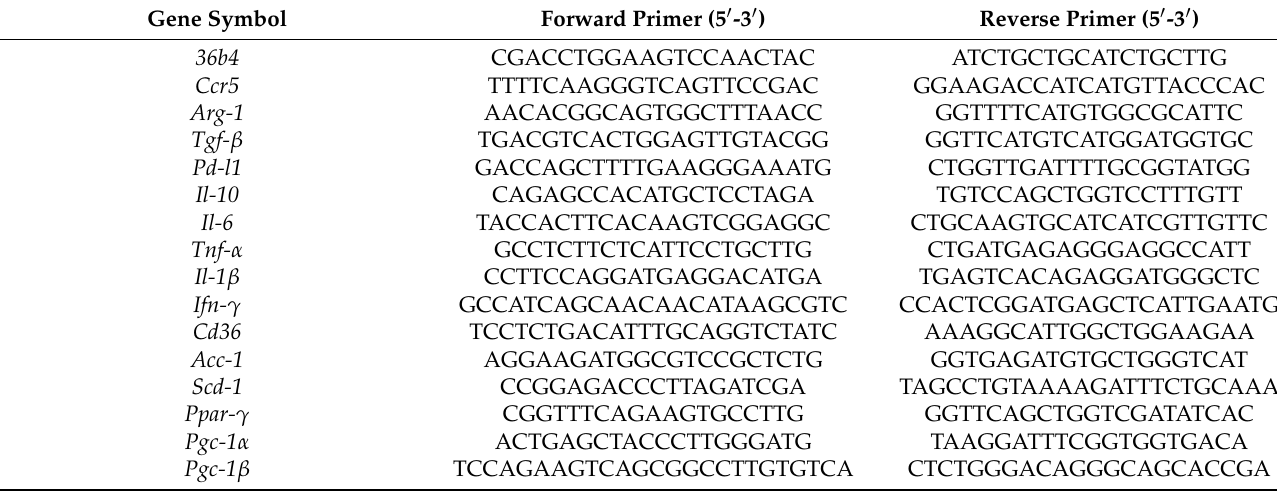
Table 1. Primer sequences for real-time RT-PCR